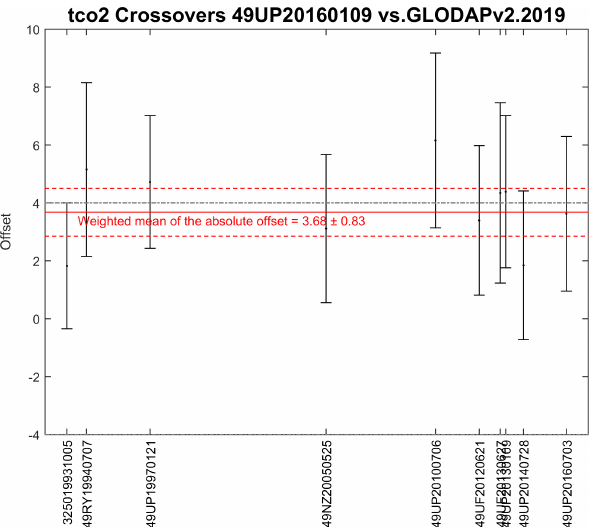
Figure 4. Example summary figure, for TCO 2 crossovers for 49UP20160109 versus the cruises in GLODAPv2.2019 (with cruise EXPOCODE listed on the x axis sorted according to year the cruise was conducted). The black dots and vertical error bars show the weighted mean offset and standard deviation for each crossover (µmolkg − 1 ). The weighted mean and standard deviation of all these offsets are shown in the red lines and are 3 . 68 ± 0 . 83µmolkg − 1 . The black dashed line is the reference line for a + 4µmolkg − 1 off- set (the corresponding line for − 4µmolkg − 1 offset is right on top of the x axis and not